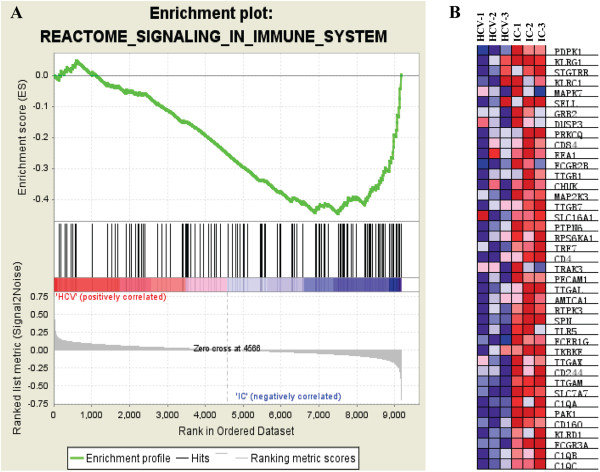
Enrichment plot and heat map for the gene set of immune system identified in comparison between HCV/HIV co-infected group and HCV mono-infected group. A. Enrichment plot for CD4+ T cells from comparison between HCV/HIV co-infected group and HCV mono-infected group. Bottom, plot of the ranked list of all genes. Y axis, value of the ranking metric; X axis, the rank for all genes. Genes whose expression levels are most closely associated with the HCV mono-infected group or HCV/HIV co-infected group get the highest metric scores with positive or negative sign, and are located at the left or right edge of the list. Middle, the location of genes from the gene set immune system within the ranked list. Top, the running enrichment score for the gene set as the analysis walks along the ranked list. The score at the peak of the plot is the enrichment score (ES) for this gene set and those genes appear before or at the peak are defined as core enrichment genes for this gene set. B. Heat map of the genes within the gene set of immune system corresponding to A. The genes that contribute most to the ES, i.e., genes that appear in the ranked list before or at the peak point of ES, are defined as core enrichment genes and highlighted by the red rectangle. Rows, genes; columns, samples. Range of colors (red to blue) shows the range of expression values (high to low).